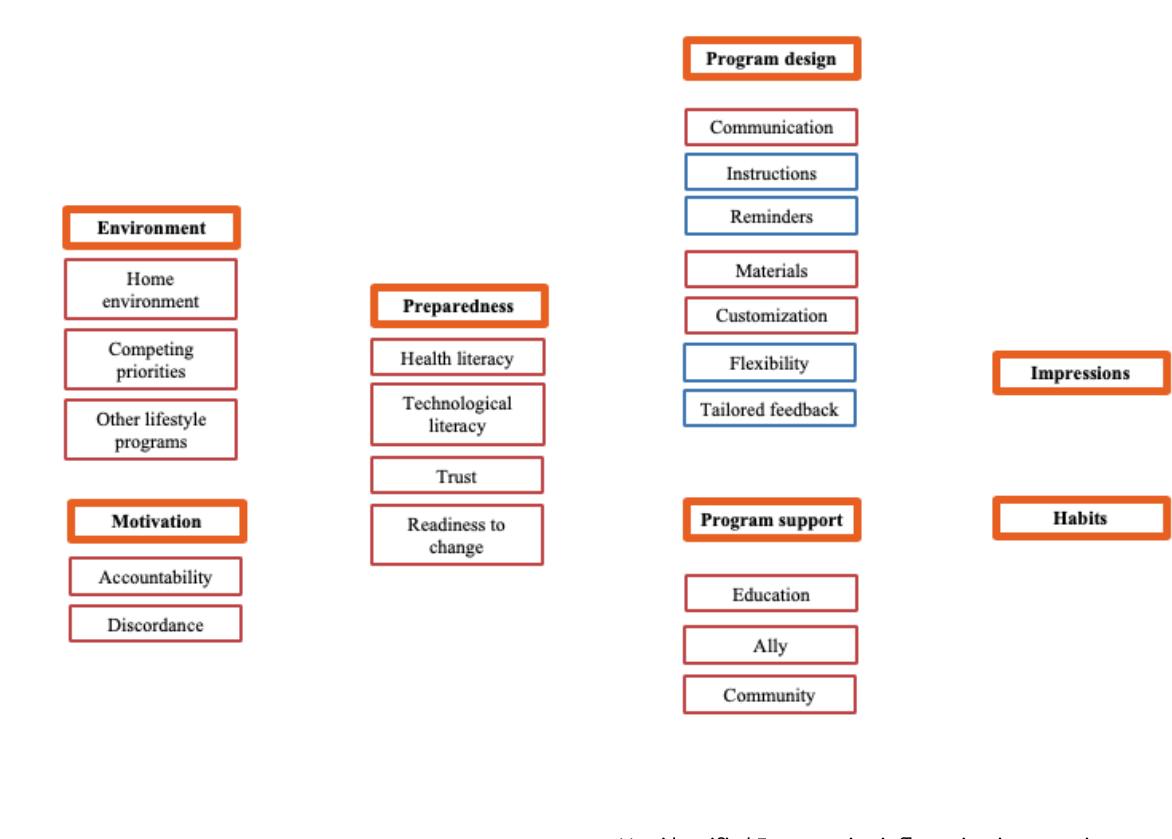
Figure 3. Codes developed using grounded theory analysis: open codes (blue), open codes elevated to axial codes (red), codes elevated to selective codes or categories